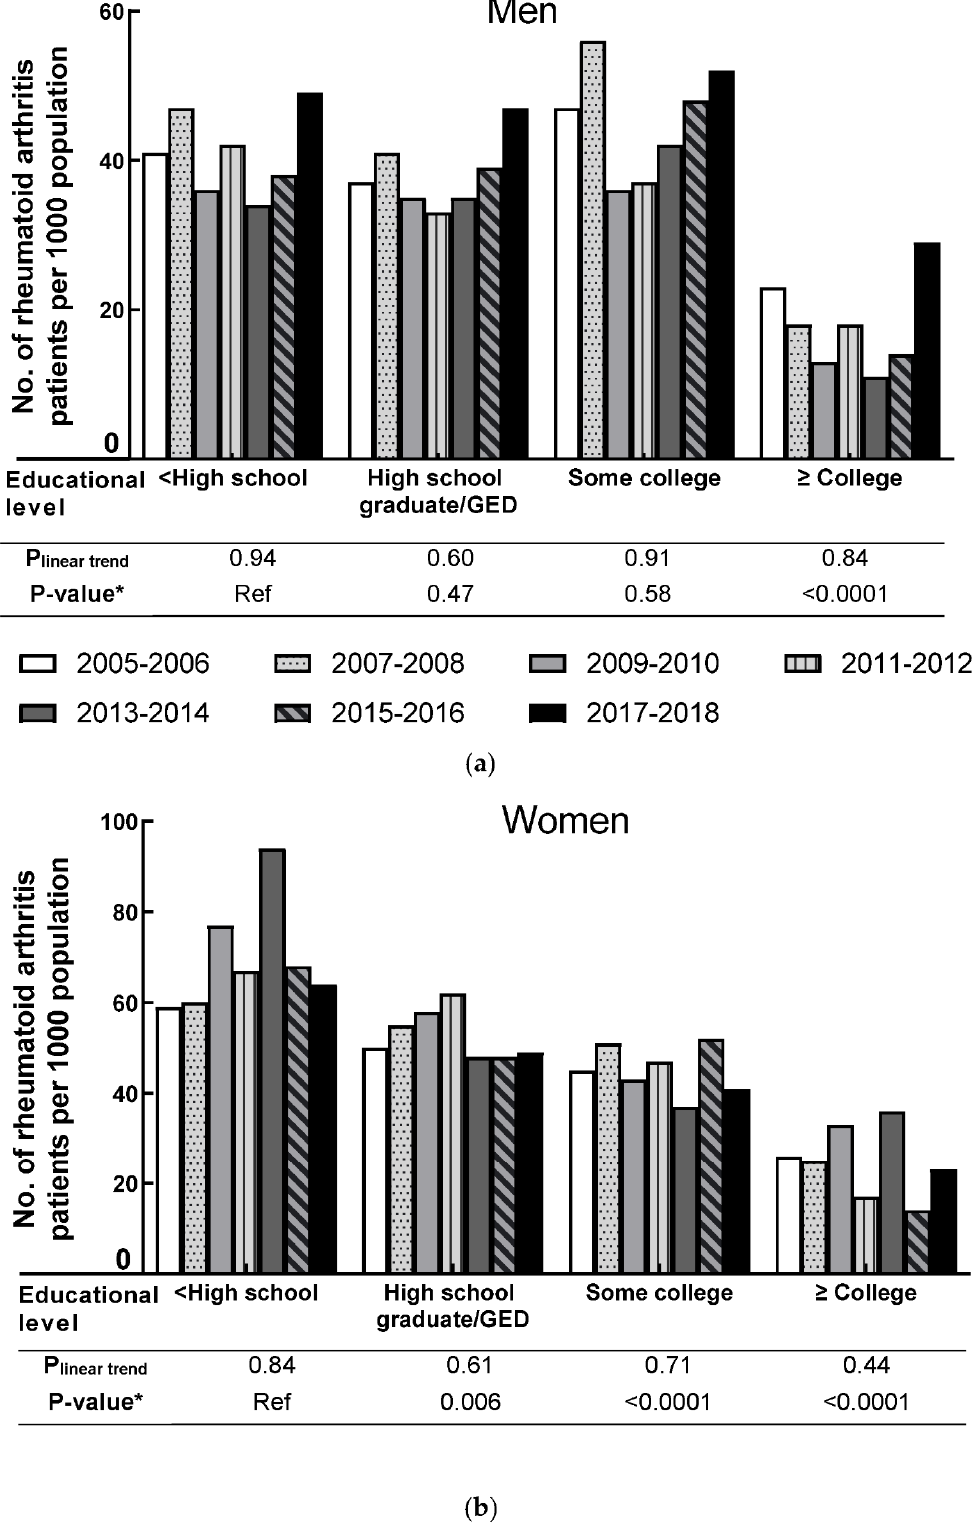
Figure 3. Age-adjusted prevalence of rheumatoid arthritis by education level in men and women, 2005–2006 through 2017–2018. ( a ) shows the prevalence of men by education level; ( b ) shows the prevalence of women by education level. * p -value was based on F-test.